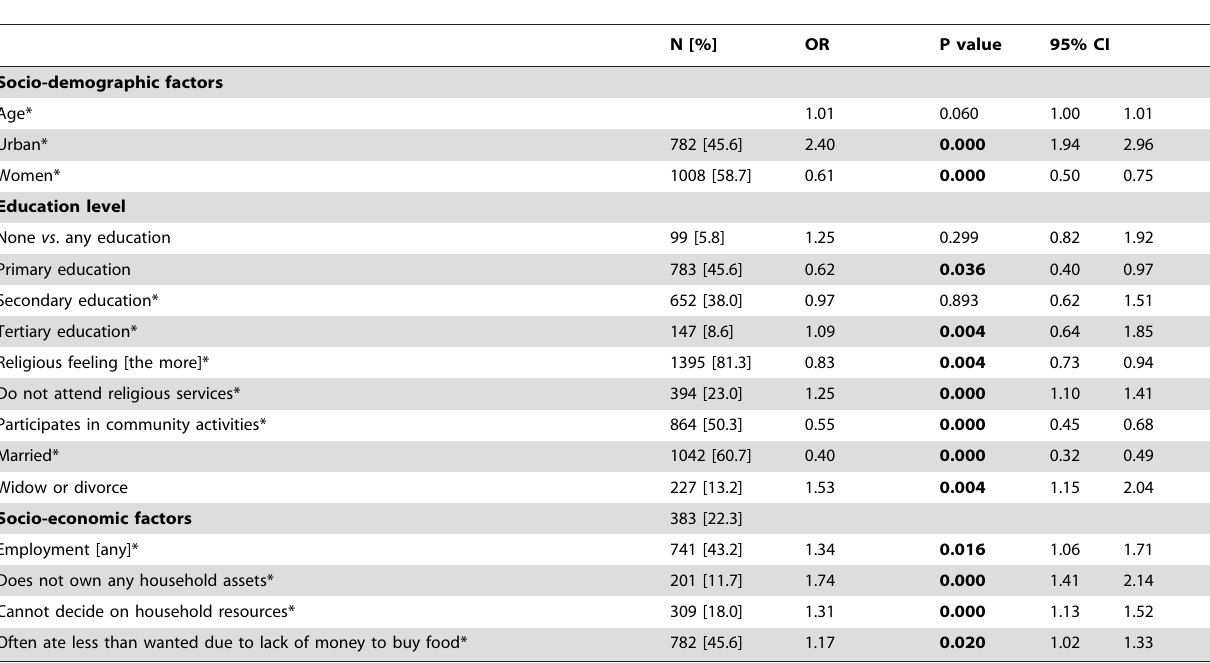
Table 4. Crude odds ratios for socio-demographic and socio-economic